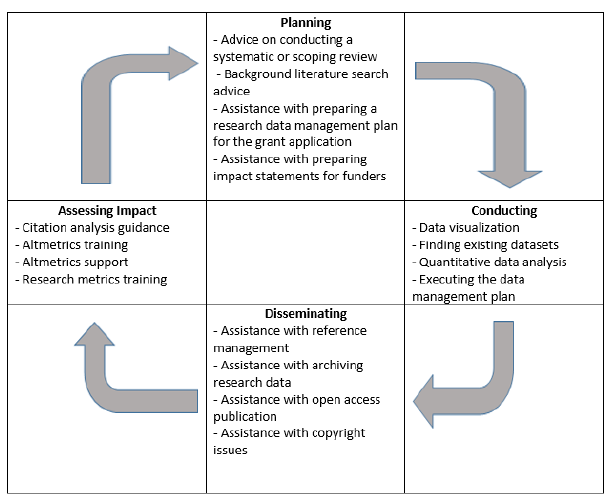
Figure 1 The Research Lifecycle as defined by Ragon with selected